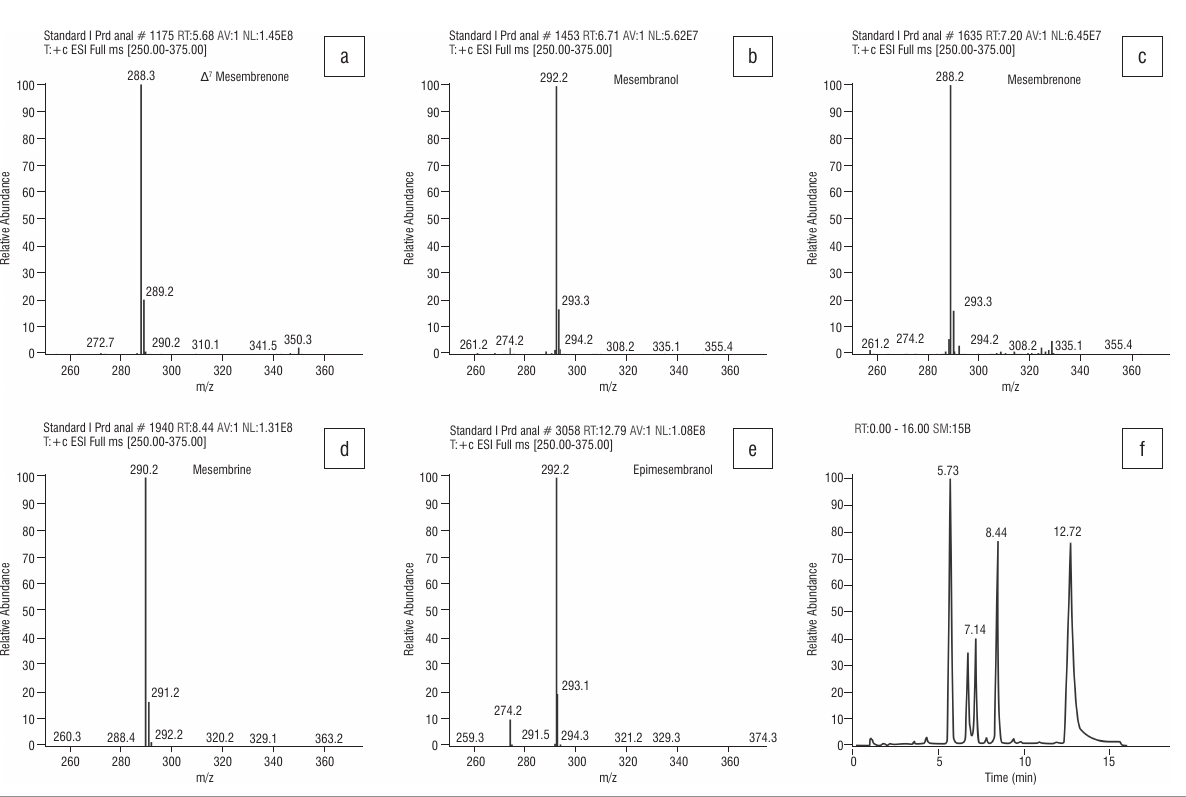
Figure 3 : The [M+H] + ions of (a) Δ 7 mesembrenone, (b) mesembranol, (c) mesembrenone, (d) mesembrine and (e) epimesembranol. (f) A mass spectrometry chromatogram of standard reference alkaloids: Δ 7 mesembrenone (5.73 min), mesembranol (6.71 min), mesembrenone (7.14 min), mesembrine (8.44 min) and epimesembranol (12.72